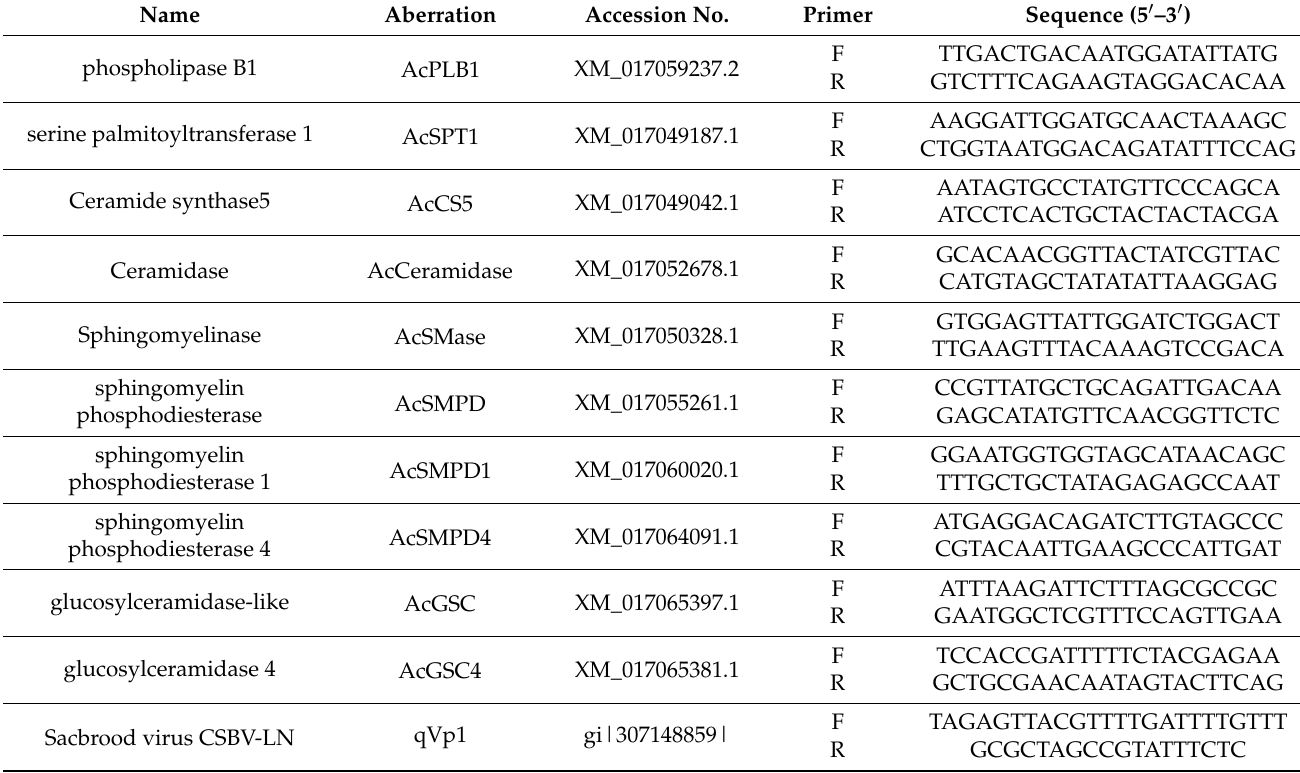
Table 1. Primers used in reverse transcription PCR and quantitative